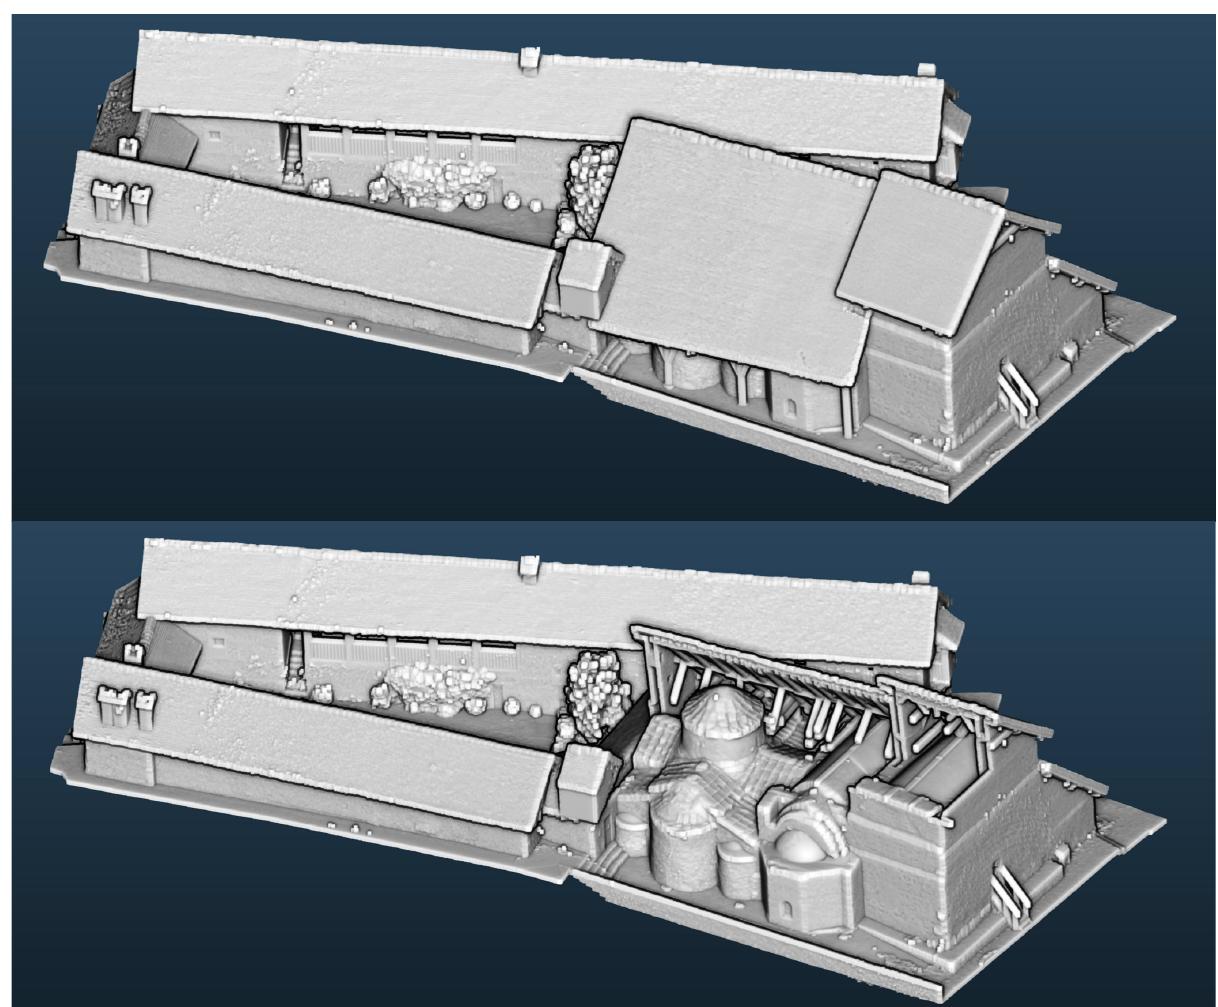
Figure 17. Agios Ioannis Lambadistis, Kalopanayotis, exterior (top), exterior with a section of the roof